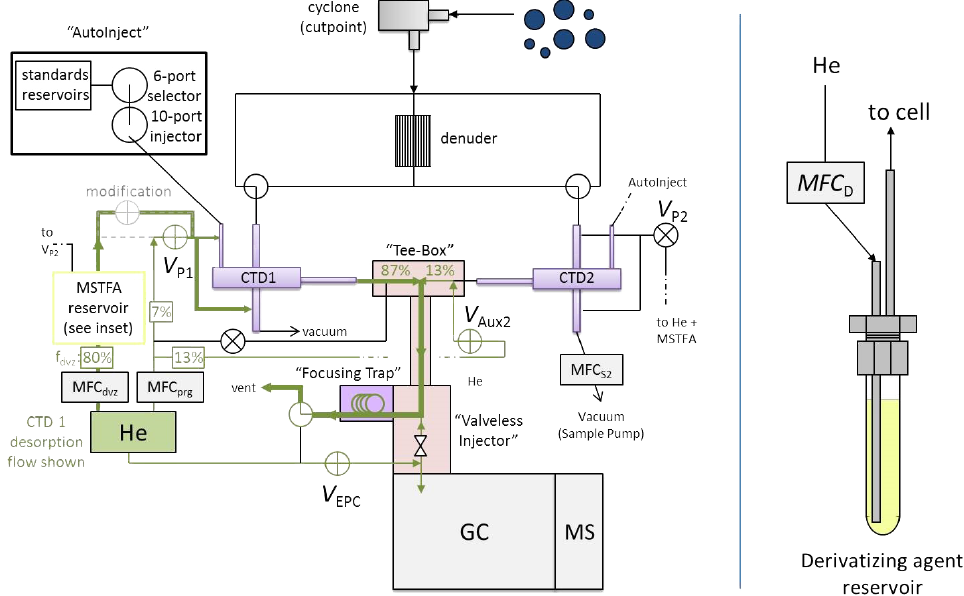
Figure 1. Schematic of dual-cell SV-TAG with in situ derivatization. Two parallel collection and thermal desorption cells (CTD) simultane- ously sample, one directly collecting gas-plus-particle-phase compounds and one through a denuder that removes all gas-phase compounds, thus collecting only particles. Each sample is transferred in series to the GC–MS through a two-stage purge-and-trap thermal desorption process. Purge helium is saturated with derivatization agent by passing through a reagent reservoir (inset). Derivatized and underivatized desorption flows are controlled independently using MFC dvz and MFC prg , respectively. Liquid standards are regularly introduced by the AutoInject. After SOAS, derivatized flow paths were decoupled from non-derivatized flow paths (modification shown in dashed gray – path with flow added, path without flow removed). Green arrows show helium flow during desorption of CTD1 assuming f dvz = 0.80, where width is approximate relative to flow